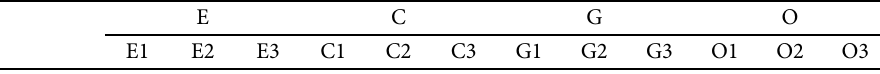
Table 6. The weighted normalized decision matrix E C G O E1 E2 E3 C1 C2 C3 G1 G2 G3 O1 O2 O3 (A1) Digital games